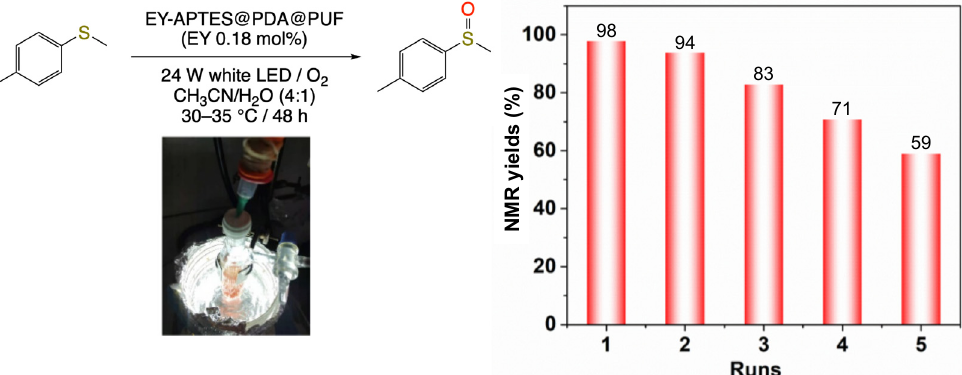
Figure 7. NMR yields measured over five successive runs of p -tolyl methyl sulfide oxidation photo- catalyzed by a single sample of EY-APTES@PDA@PUF. Reaction conditions: methyl p -tolyl sulfide (0.5 mmol), EY-APTES@PDA@PUF (2 cm × 2 cm × 2 cm, 0.18 mol% eosin Y), CH 3 CN/H 2 O (4:1) (20 mL), 24 W white LED, O 2 balloon, 30–35 °C due to LED light heat, 1000 rpm.